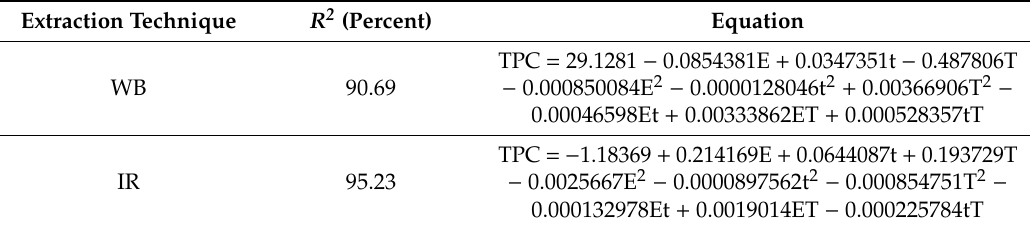
Table 4. Second order regression equation for TPC of each extraction technique and the R-squared of each equation.